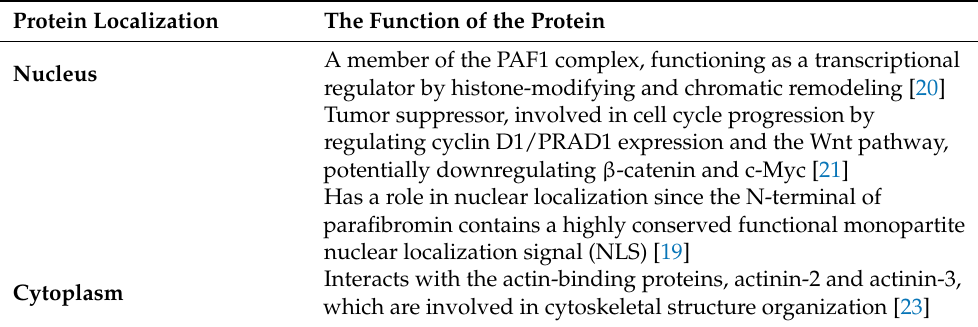
Table 1. Major biological functions of wild-type parafibromin